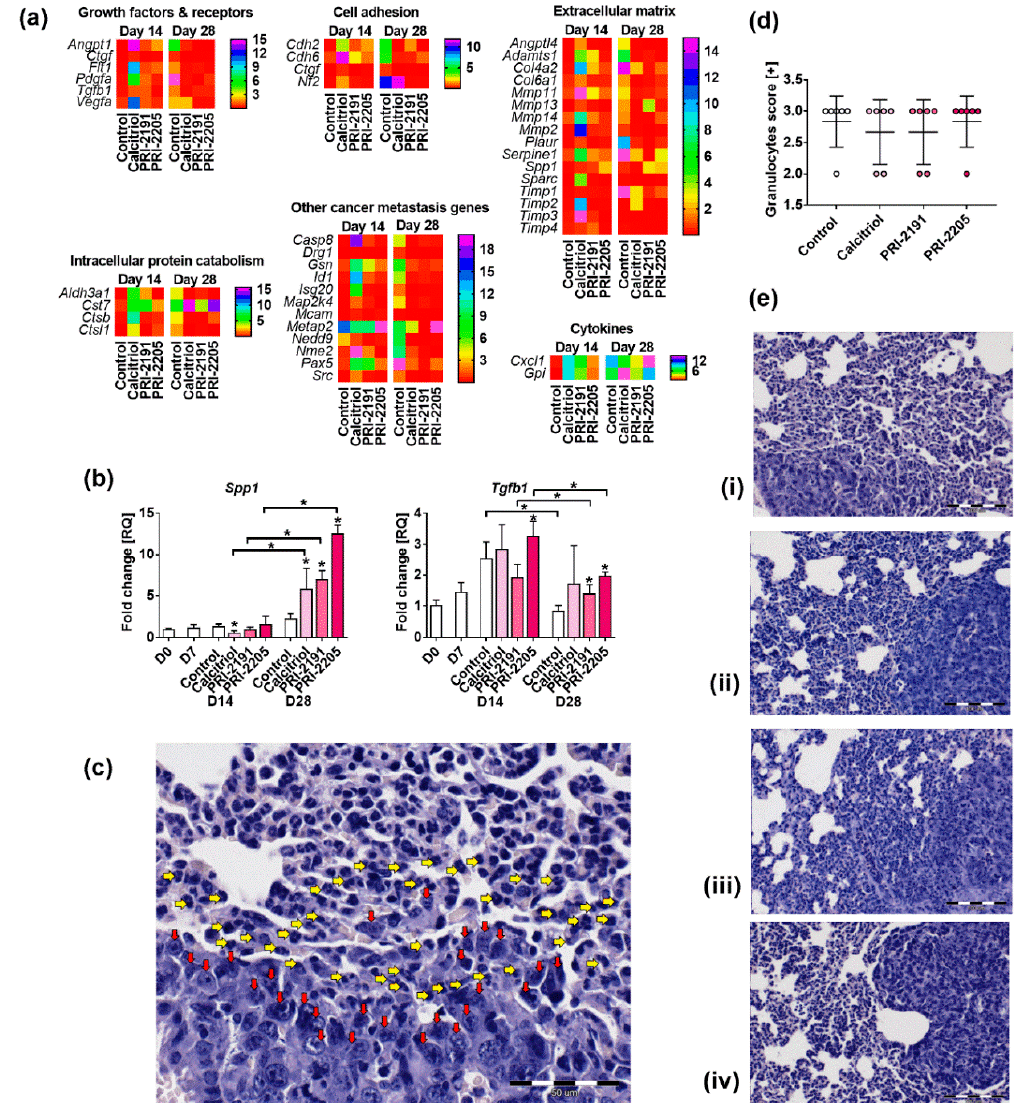
Figure 6. Changes in mRNA expression and granulocyte infiltration in lung from mice treated with calcitriol and its analogs. ( a ) Screening of genes correlated with tumor invasion and metastasis using real-time PCR; ( b ) real-time PCR analysis of two selected genes; ( c – e ) lung infiltration by granulocytes: ( c ) representative picture of lung tissue with metastatic focus (magnification of 400 × , scale bar 50 µ m) infiltrated by granulocytes. On the margin of tumor tissue: red arrows—nuclei of tumor cells, yellow arrows—nuclei of granulocytes; ( d ) scoring of granulocytes infiltration in lung tissue; ( e ) representative pictures of lung tissue sections (magnification of 200 × , scale bar 100 µ m): ( i ) control, ( ii ) calcitriol, ( iii ) PRI-2191, and ( iv ) PRI-2205. Number of mice evaluated were 3–7 per group. Data presentation: ( a ) heat maps presenting mean relative quantification (RQ) values from duplicates. Fold-change (RQ) of target cDNA was determined by calculating the differences in ∆∆ CT values with reference to ribosomal protein L13A ( Rpl13a ) and adjusted to the values obtained for the untreated mice (named D0) for each treatment group; ( b , d ) mean ± SD. Statistical analysis: Kruskal–Wallis multiple comparison test, * p < 0.05.